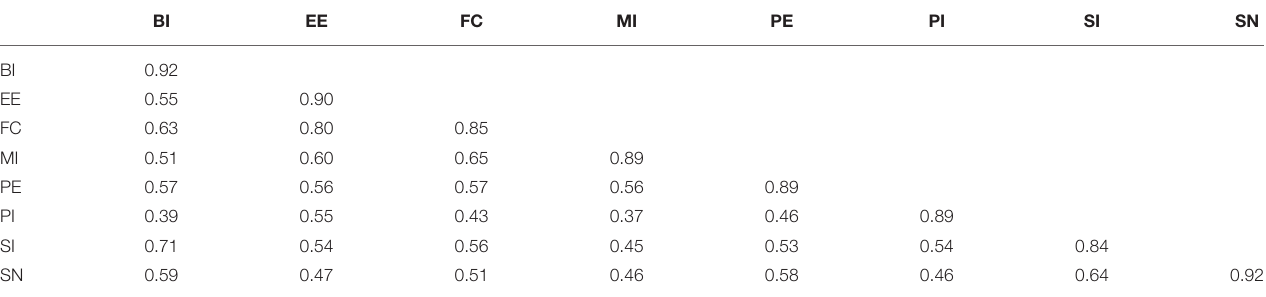
TABLE 6 | Discriminant validity – the square root of average variance extracted (AVE)>latent variable correlation (LVC).